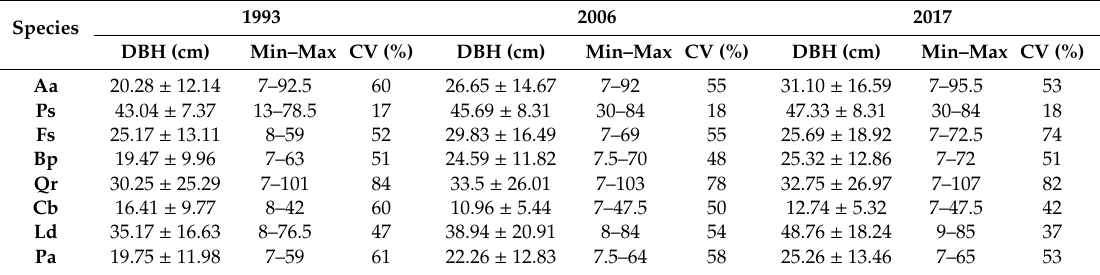
Table 2. Mean diameter, standard deviation (± SD), min-max values, and coefficient of variation (CV) of tree species present in the multispecies, uneven-aged forest in 1993, 2006 and 2017. Species